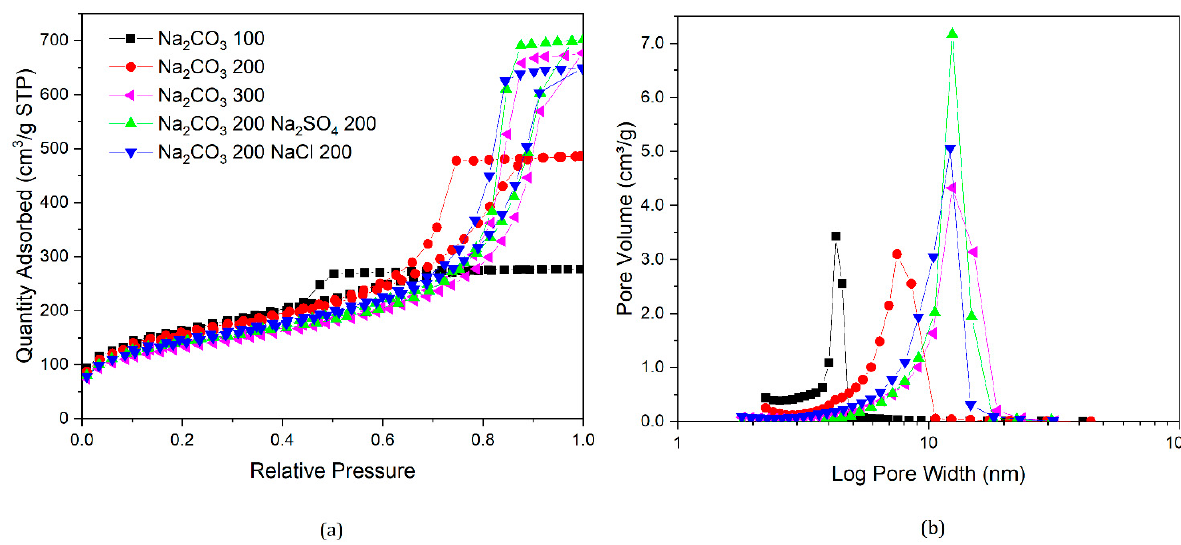
Figure 7. Nitrogen sorption isotherms of gels with varying catalyst compositions ( a ), and corresponding pore size distributions ( b ).